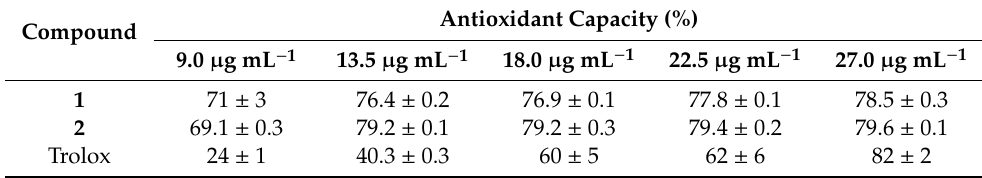
Figure 2. Percentage of remaining hydroxyl radical (OH ● ). Table 1. Antioxidant capacity of compounds 1 , 2 and Tx against hydroxyl radical (OH ● ) radical.